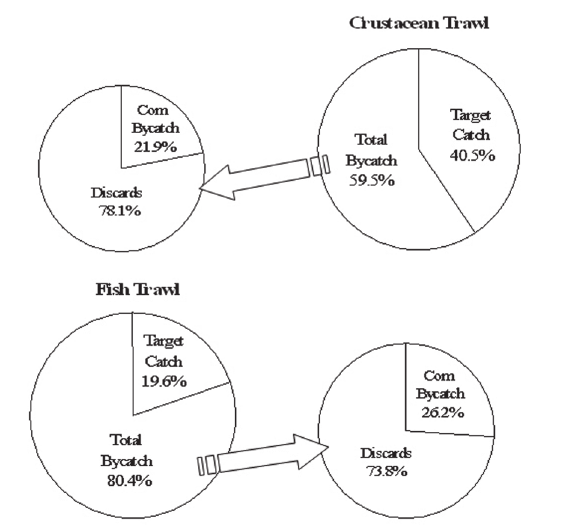
Fig . 2. – overall catch composition of the crustacean trawl and fish